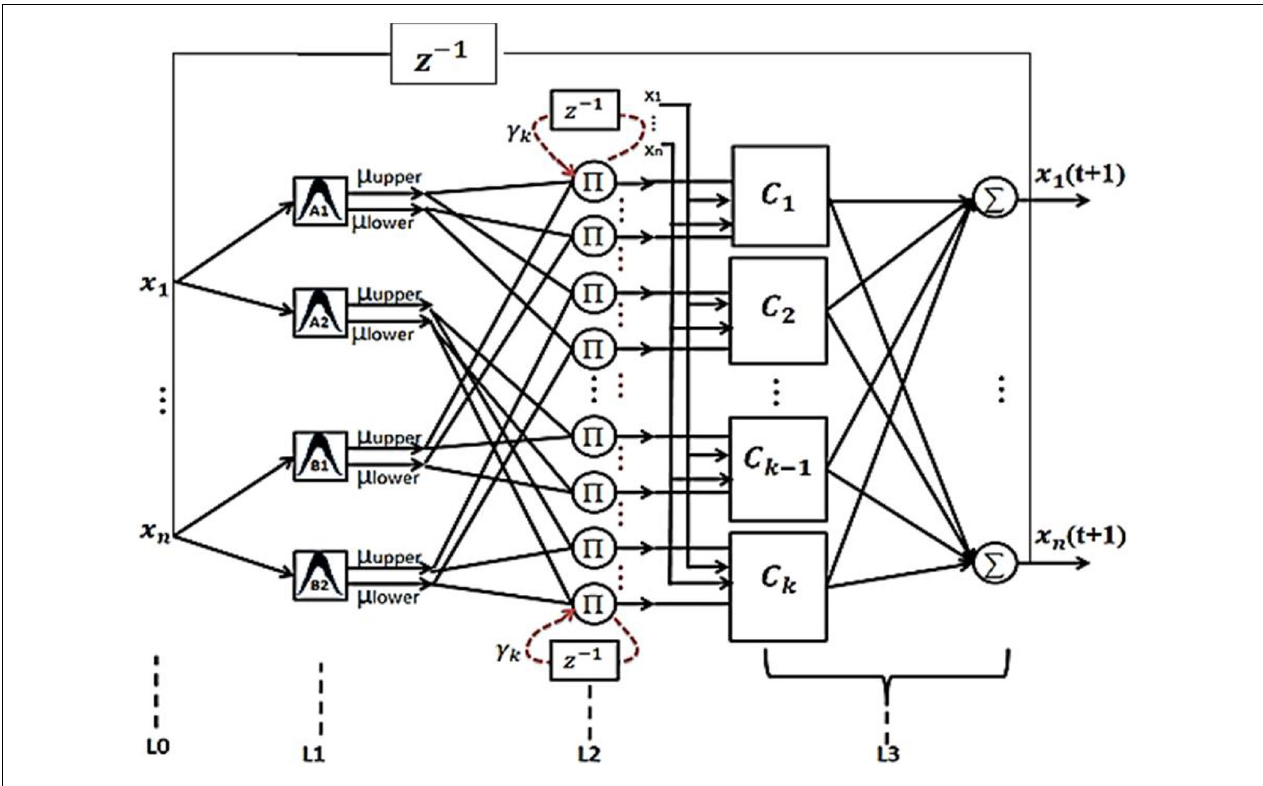
FIGURE 3 | The proposed recurrent type-2 fuzzy neural network structure.